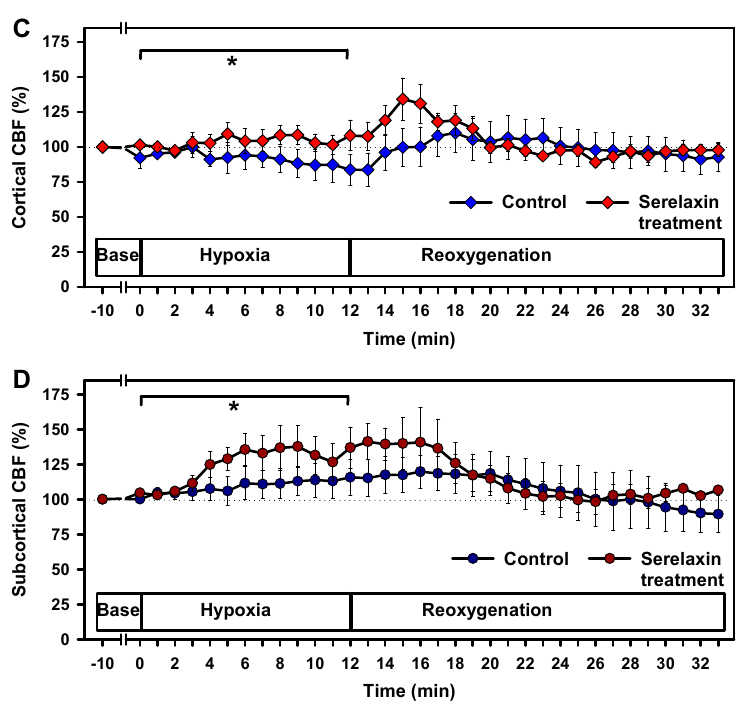
Figure 4. Effects of hypoxia and reoxygenation on cortical and subcortical cerebral blood flow (CBF).